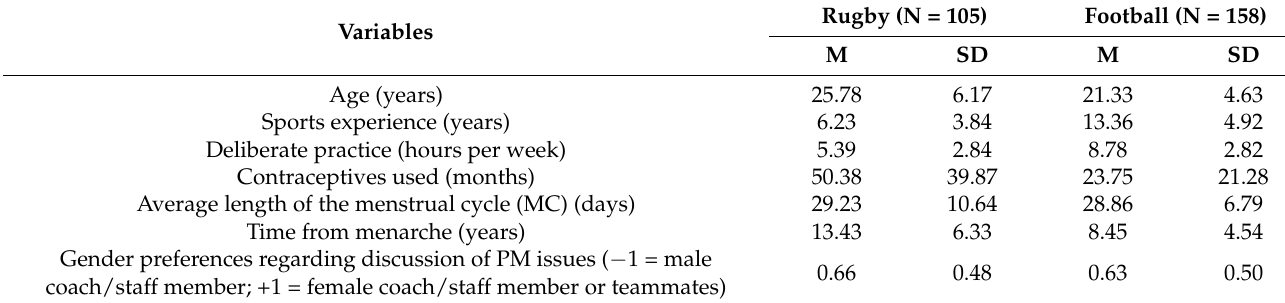
Table 1. Descriptive characteristics of the